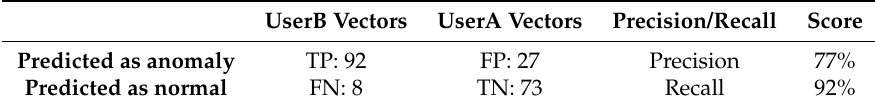
Table 6. UserA (normal) vs. UserB (anomalous) confusion matrix.